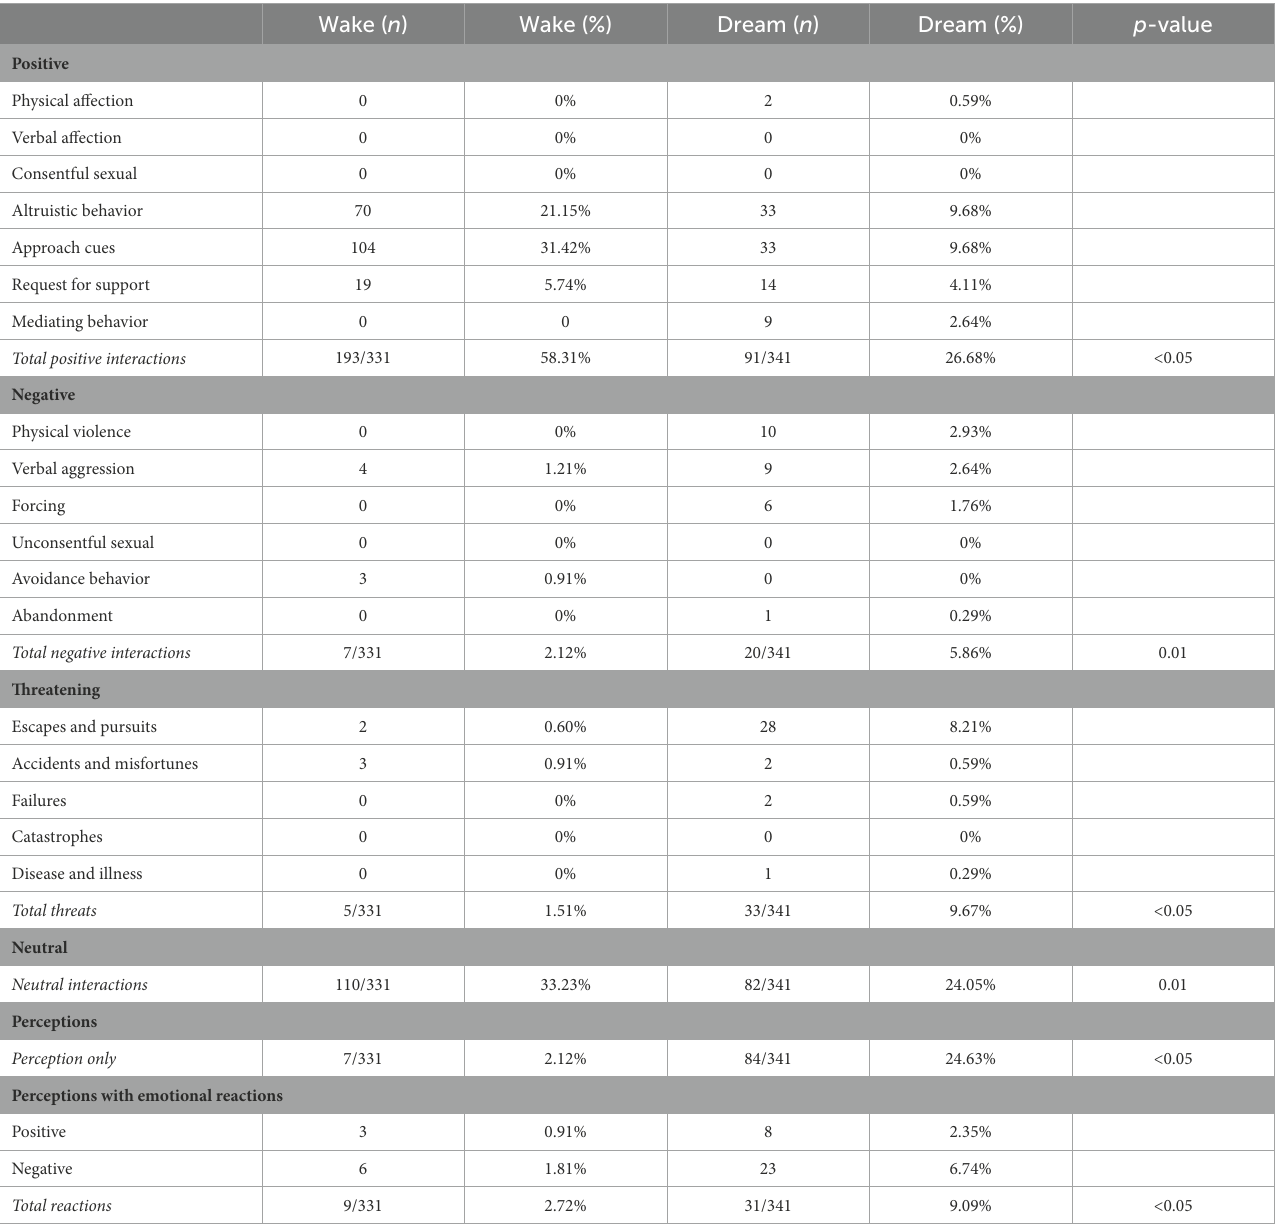
TABLE 2 Subcategories of social situations in wake ( n = 184) and dream ( n = 168)